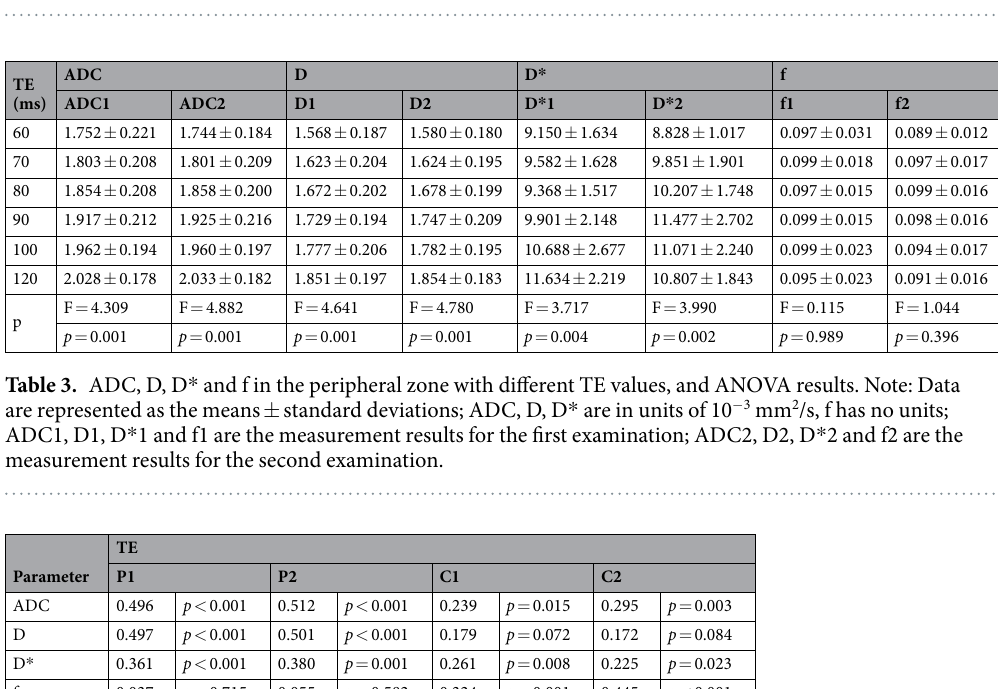
Table 2. Bland-Altman limits of agreement(BA-LA, in %) for the ADC, D, D * and f in the peripheral zone and central zone.